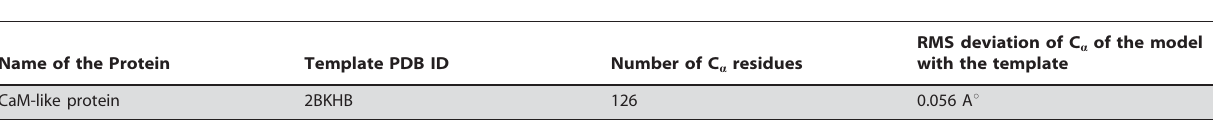
Table 2. Comparison of models with the